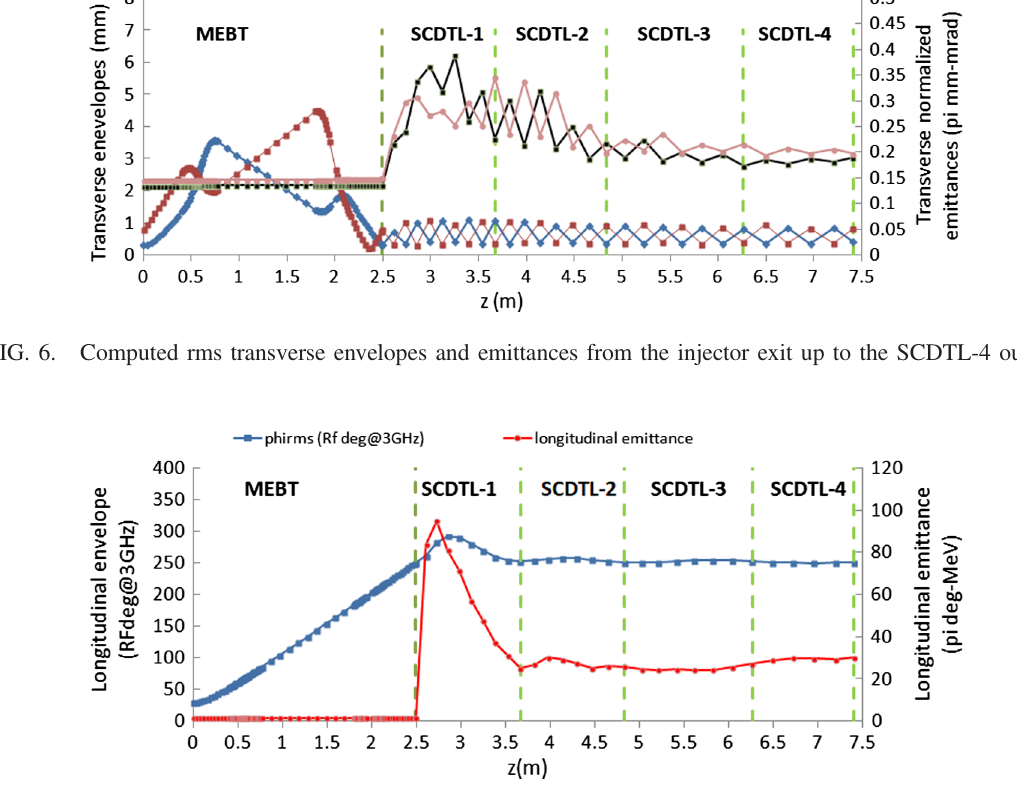
FIG. 7. Computed rms longitudinal envelope and emittance from the injector exit up to the SCDTL-4